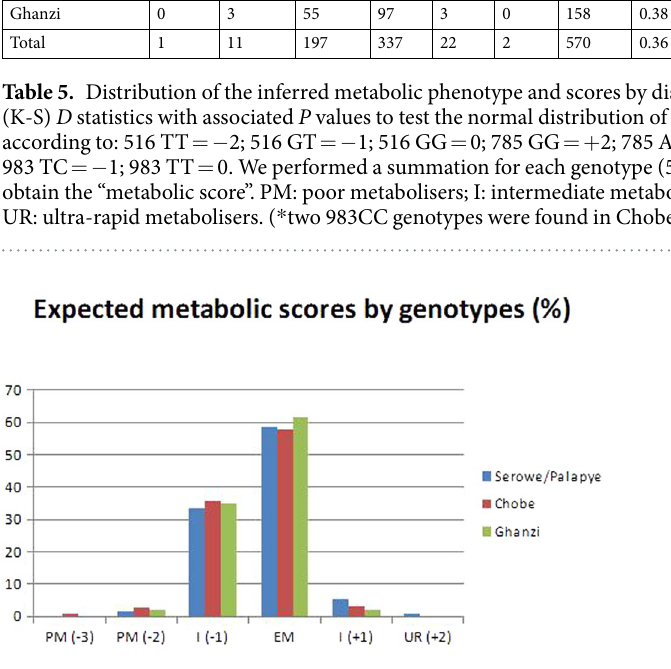
Figure 2. Distribution of the inferred metabolic scores by districts. PM = poor metabolisers; I = intermediate metabolisers (either with delayed or increased metabolism); EM = extensive or ‘normal’ metabolisers; UR = ultra-rapid